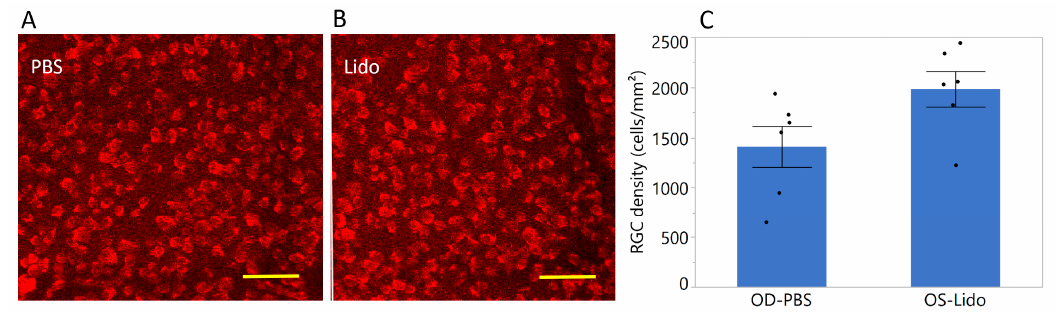
Figure 5. Retrobulbar lidocaine is neuroprotective in early DBA/2J glaucoma. ( A , B ) examples of confocal images of RBPMS-positive RGCs in whole-mounted retinas of one nine-month-old D2 that received four retrobulbar injections of lidocaine at four months of age in one eye ( B ) and an equal volume of PBS in the other eye ( A ), scale bar, 50 µm; ( C ) Mean RGC density in D2 mice nine mo. old treated with retrobulbar lidocaine in one eye and PBS in the contralateral eye at four months of age. RGC density is higher in lidocaine-treated eyes by 35% ( p = 0.04). Error bars represent the SEM, N = 6. Black dots represent measurements in individual mice.